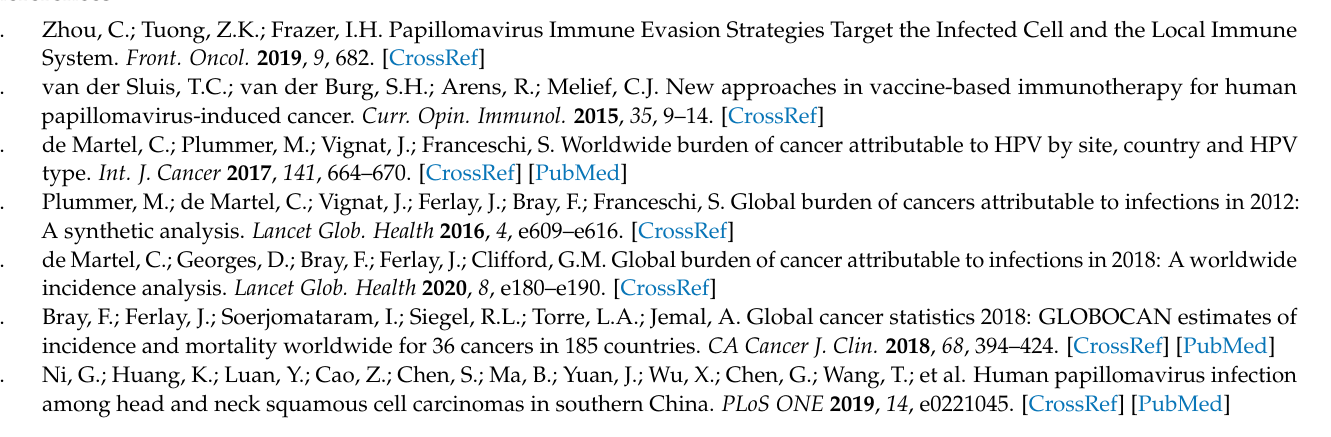
cytometry; Table S2: ELISA results; Table S3: The results of qPCR analysis and survival